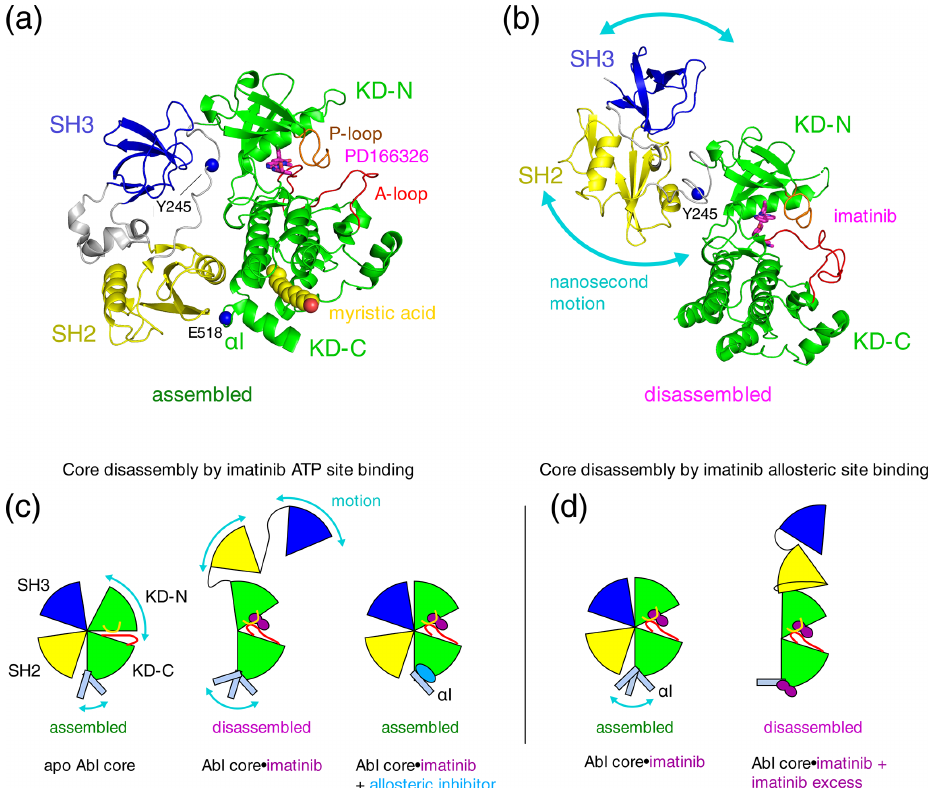
Figure 1. Proposed mechanisms of imatinib-induced disassembly of Abl’s regulatory core. (a) Crystal structure of Abl regulatory core (PDB ID: 2FO0) in complex with ATP-site inhibitor PD166326 (magenta sticks) and myristic acid (yellow spheres). Abl SH3 (blue) and SH2 (yellow) domains, KD N- and C-lobes (“KD-N”, “KD-C”, green), and linker regions (grey) are shown as cartoon. Residues Y245 (see text) and E518 (end of Abl 248–518 construct used for crystal structure in P3) are shown as single blue spheres. (b) Model of Abl 83–534 · imatinib complex as derived by rigid-body refinement with RDC and SAXS data in P1. The calculations revealed a large range of possible relative positions of SH3, SH2, and KD domains in agreement with the large-amplitude relative motions of the domains that were observed by 15 N relaxation data. Only one of these conformations is shown in the panel. (c) Mechanical model explaining the allosteric coupling between A-loop and P-loop conformations, the flexibility of the α I helix, and the Abl core assembly state induced by ATP- and allosteric-site ligands as proposed in P2. Binding of the type-II inhibitor imatinib (magenta) to the ATP site induces a rotation of the kinase N-lobe towards the SH3 domain, which together with forces exerted by the flexible α I helix onto the SH2 domain leads to core disassembly. Binding of allosteric-site inhibitors such as GNF-5 or asciminib to the myristoyl pocket fixes the α I helix in one conformation that does not clash with the SH2 domain and reassembles the core even in the presence of type-II ATP-site inhibitors. (d) Mechanism proposed in P3 to explain imatinib-induced disassembly of Abl’s core. Binding of imatinib to the ATP site does not disassemble the core. However, after saturating the ATP site, low- affinity binding of imatinib to the allosteric site exerts forces onto the KD–SH2 interface that lead to core disassembly. The disassembled state is not dynamic but a fixed